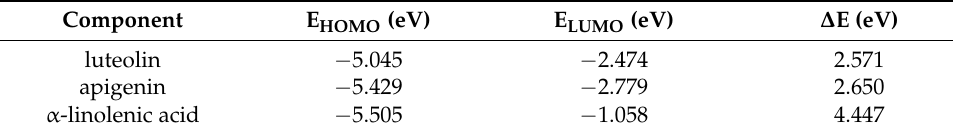
Table 2. Chemical calculation results of corrosion inhibitor